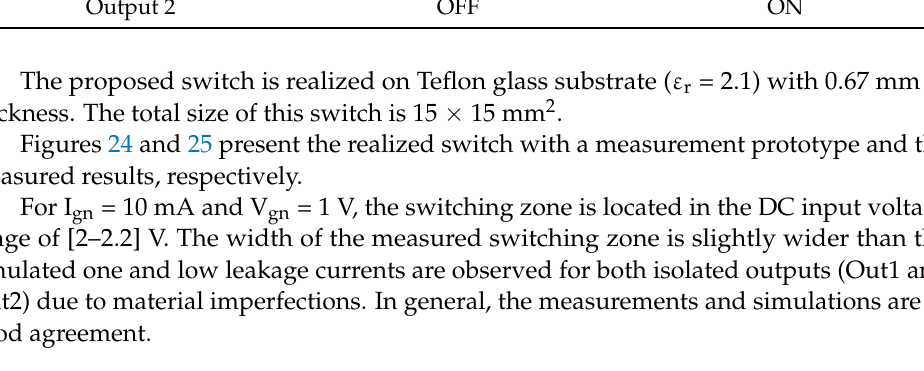
Figure 23. ( a ) Equivalent circuit for high input powers, ( b ) Equivalent circuit for low input pow- ers .